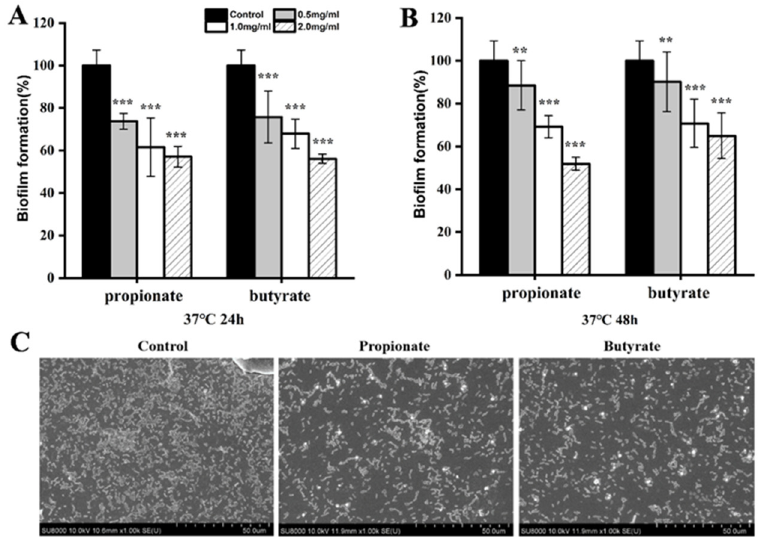
Figure 2. Biofilm formation of S. Typhimurium SL1344 grown in LB for ( A ) 24 h at 37 ◦ C and ( B ) 48 h at 37 ◦ C. ( C ) The SEM of biofilm at 1000 × magnification. “**” and “***” indicates significance compared to the control. “*” p < 0.05, “** ” p < 0.01, “***” p < 0.001.